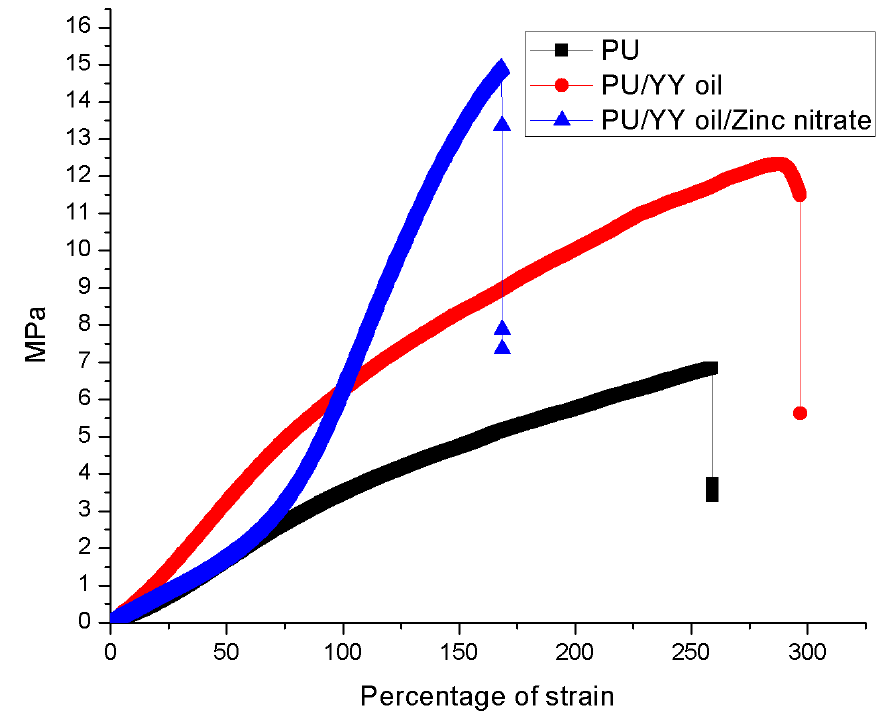
Figure 7. Tensile strength of PU, PU/YY and PU/YY/ZnNO 3.